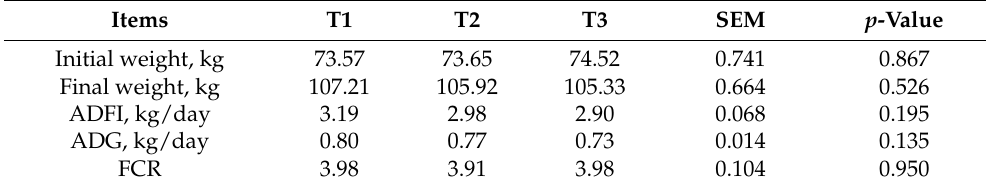
Table 3. Productive performance of a finishing crossbred pigs fed a low-lysine diet supplemented with perilla cake.